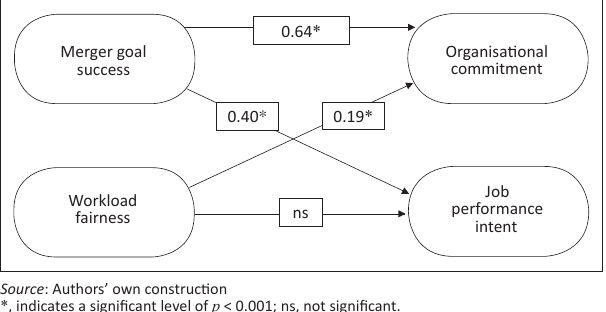
FIGURE 1: The relationship between merger goal success, perceptions about merger outcomes, organisational commitment and job performance